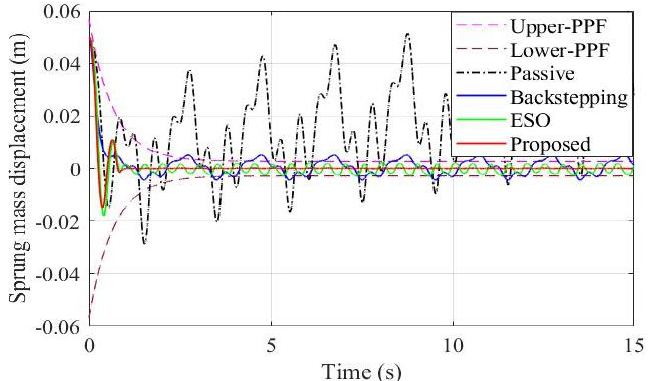
Figure 3. Simulation result of sprung mass displacement.